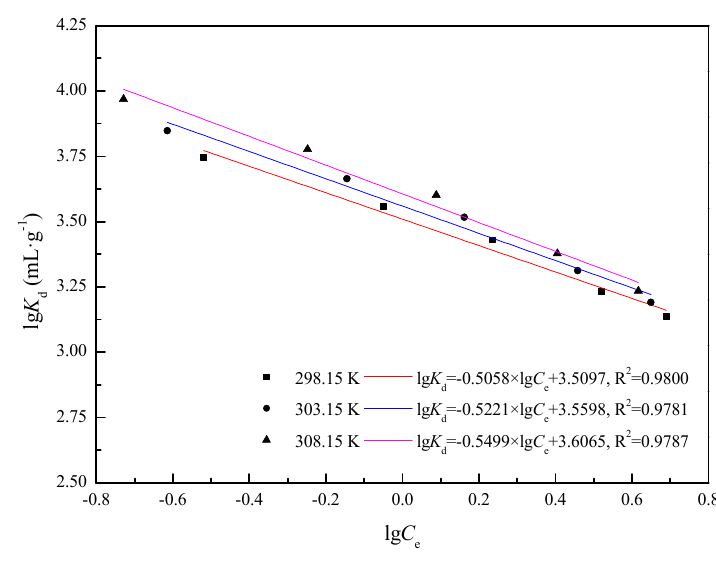
Figure 4. Plots of ln K d − lg C e of IB.